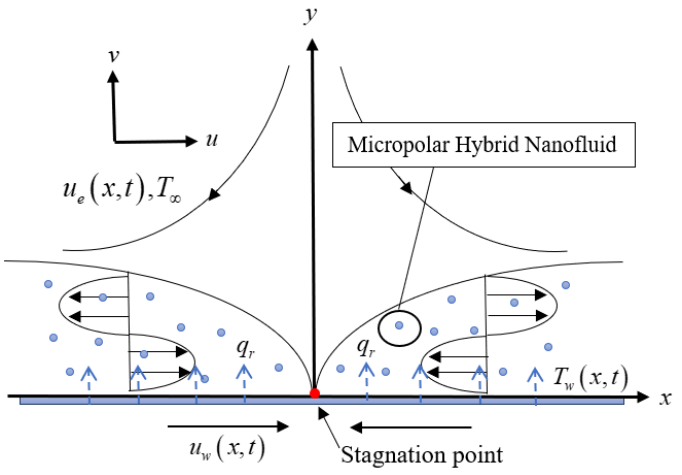
Figure 1. Schematic model of shrinking sheet.